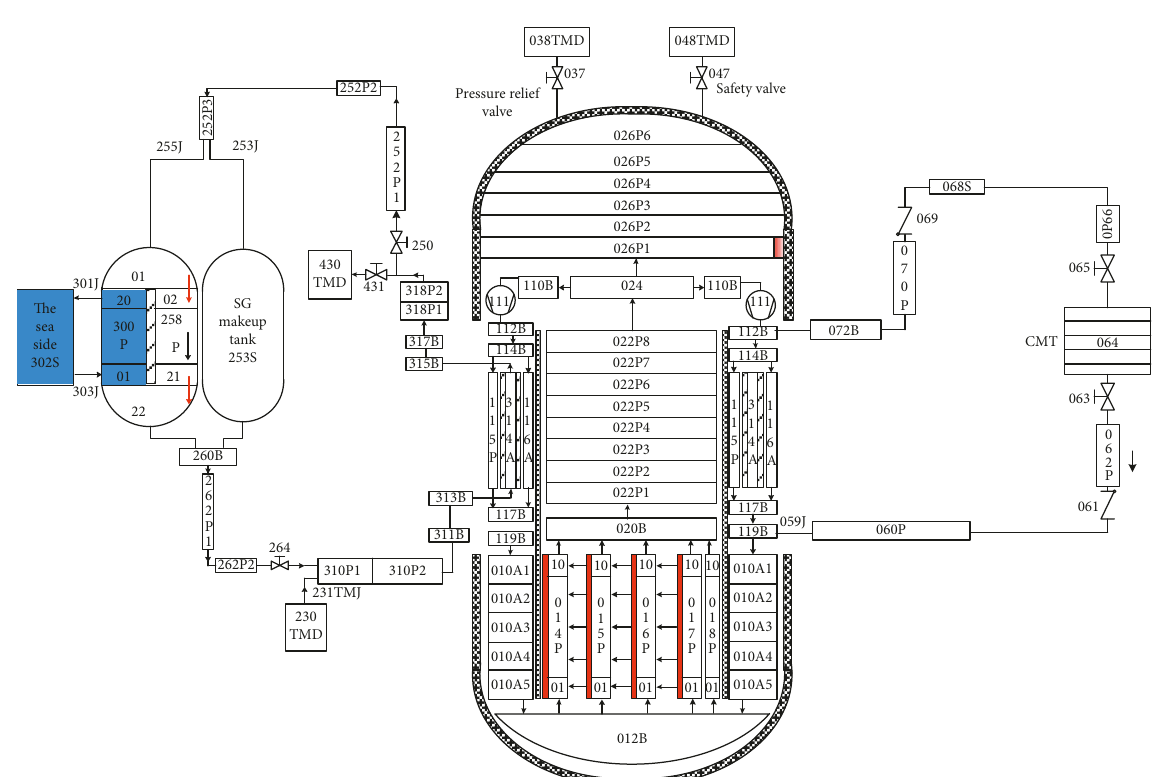
Figure 2: Nodalization of reactor and safety system.